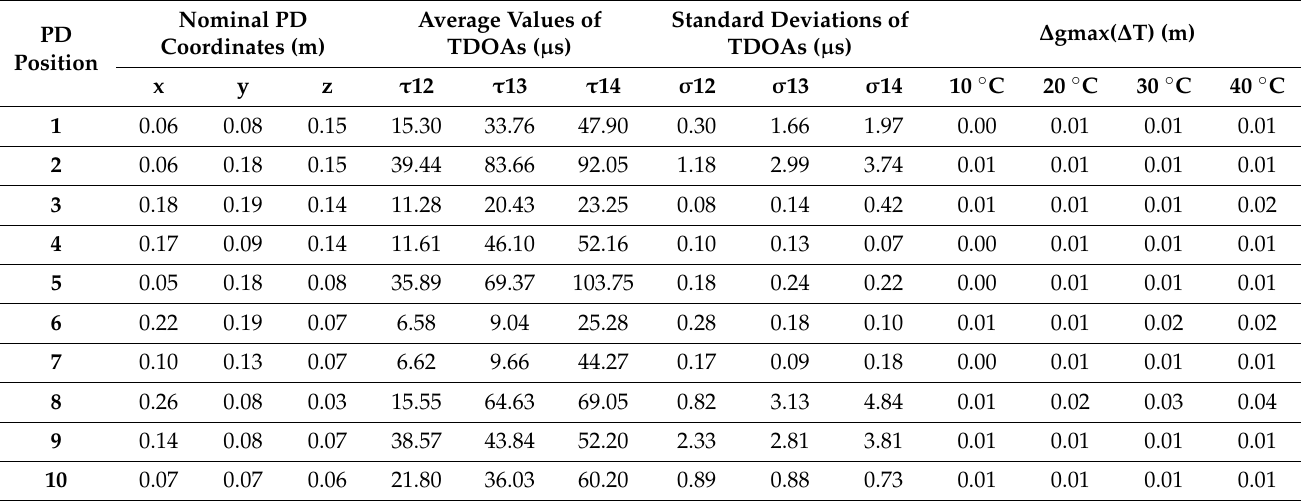
Table 3. Experimental verification of the results of Simulation 1. The results show that, for the PDs placed close to the sensors, ∆ gmax remains below 0.05m even for oil-temperature change of 40 ◦ C.